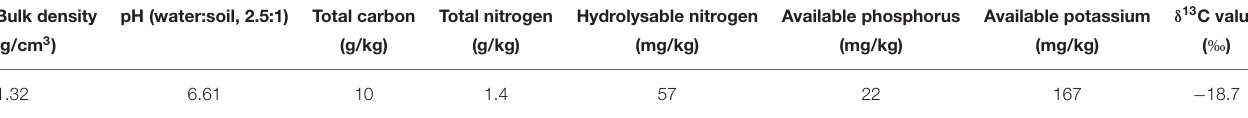
TABLE 1 | Physical and chemical properties of soil (0–40cm